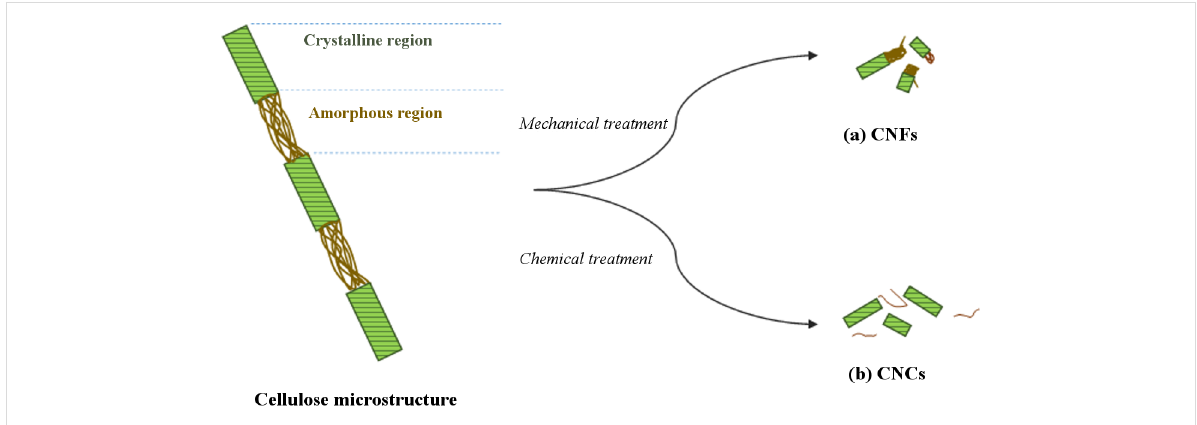
Figure 2: The structures of (a) cellulose nanofibers (CNFs) and (b) cellulose nanocrystals (CNCs) produced from cellulose.